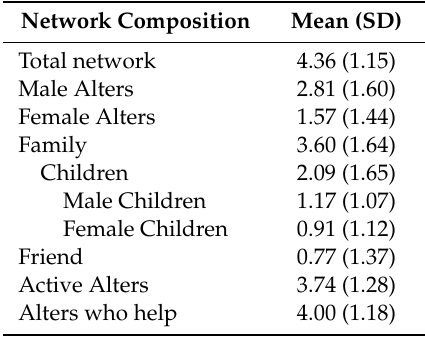
Table 2. Father network composition means and standard deviations.